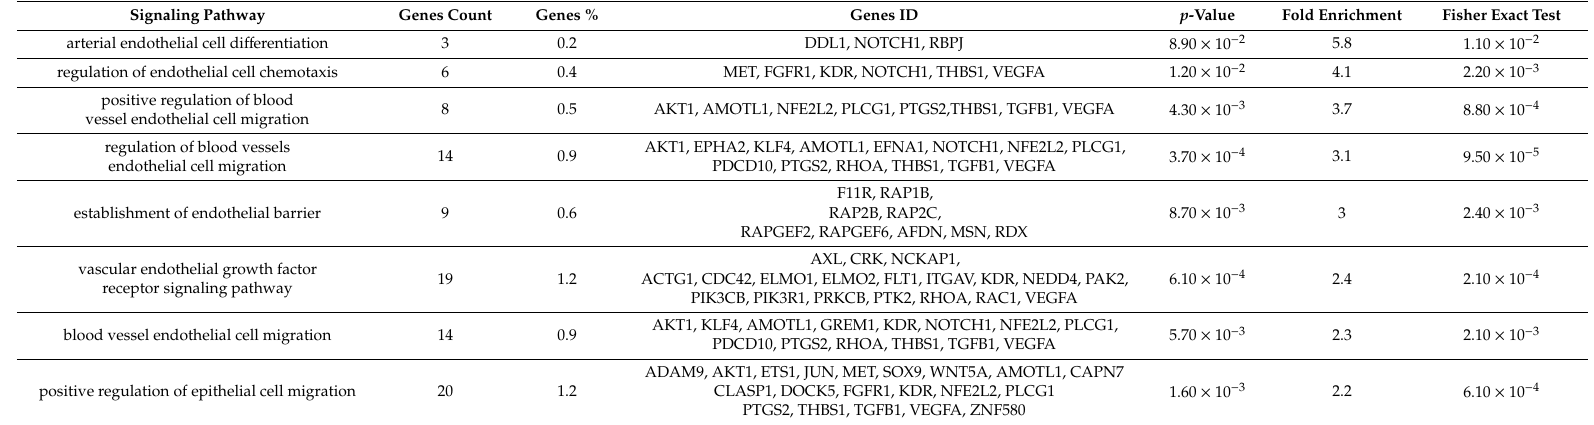
Table 3. List and details of most important signaling pathways in which validated target genes of miR-200b-3p, miR-365-3p and miR-199a-3p are involved. The first column indicates the biological process in which a specific number (second column) of validated target genes of miR-200b-3p, miR-365-3p and miR-199a-3p are involved. The following columns list the respective p values (third column), fold enrichment (fourth column) and Fisher’s exact test corrected p values (fifth column). DLL1: delta like canonical Notch ligand 1; NOTCH1: Notch 1; RBPJ: recombination signal binding protein for immunoglobulin kappa J region; MET: